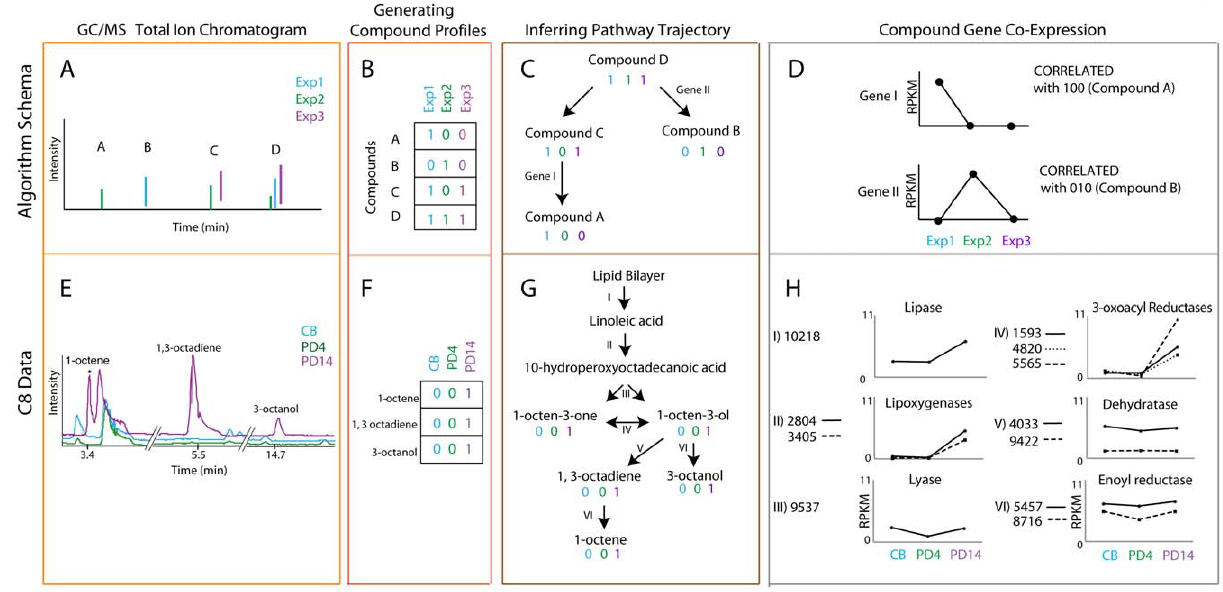
Figure 3. Coupled transcriptomics and metabolomics to generate pathway predictions. The top panels (A–D) represent the algorithm schema and the bottom panels (E–H) represent the corresponding steps with data for an example pathway, C8 production. Cyan, green, and purple are used to denote different experimental conditions (1, 2, and 3 and CB, PD4, and PD14 for the schematic and the C8 pathway data, respectively). GC/MS total ion chromatograms (orange box, A & E) are used to generate compound co-occurrence profiles (red box, B & F). These compound co- occurrence profiles are used to group and order the compounds based on patterns of correlation and anti-correlation to build a possible biosynthetic pathway (brown box C & G). Genes for which the expression profile matches the compound profile are considered correlated and therefore likely candidates for the biosynthetic pathway of interest (gray box D & H). Retrosynthesis is then used to match correlated genes with a reaction in the pathway, represented by roman numerals denoted on pathway arrows (brown box, C&G).